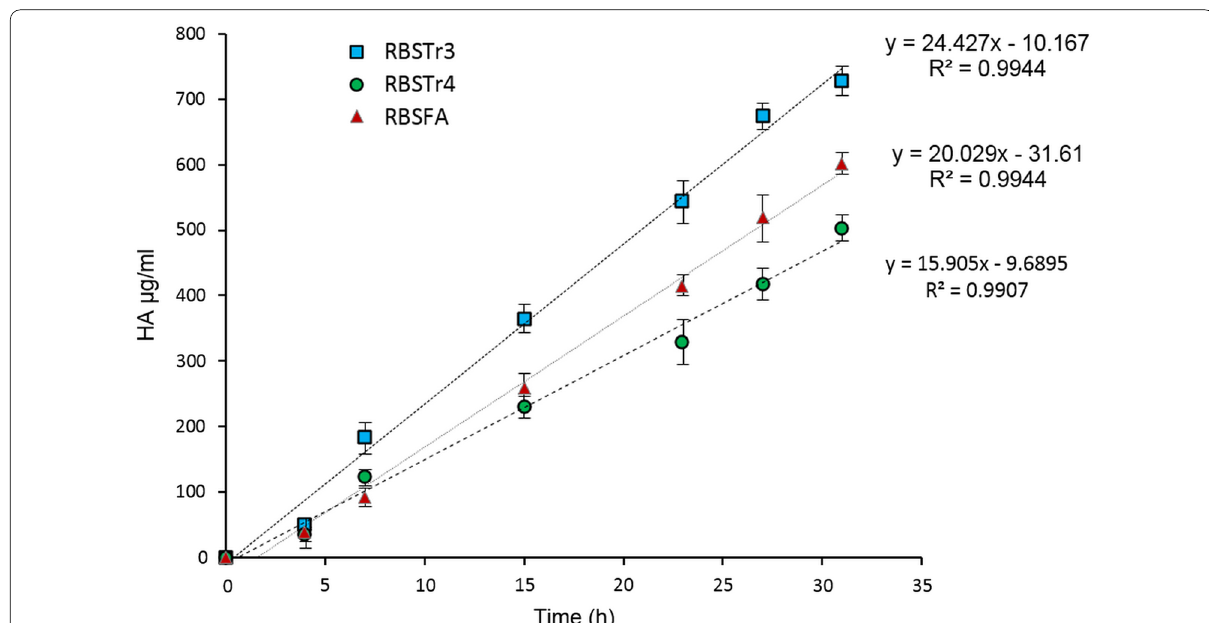
Fig. 3 Production rate of HA by RBSFA, RBSTr4 and RBSTr3. HA production in all strains was linear until 31 h with a production rate of 15.9, 20, and 24.4 mg/L.h − 1 for RBSFA, RBSTr4, and RBSTr3 strains,